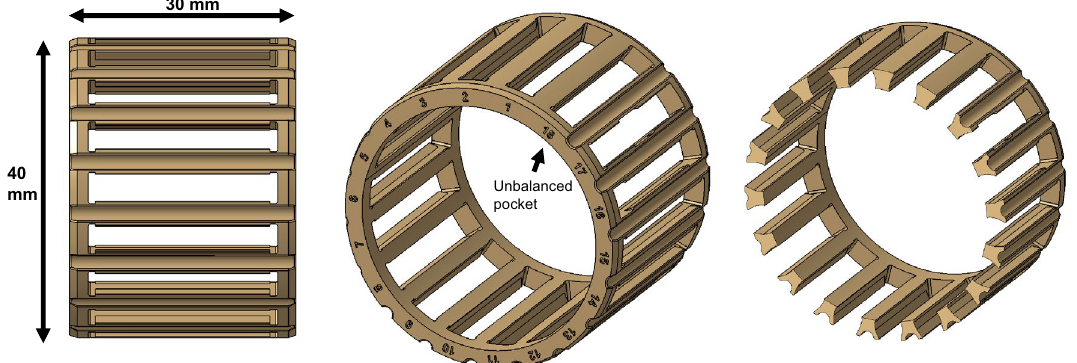
Figure 2. The design of the polymeric cage with 18 different